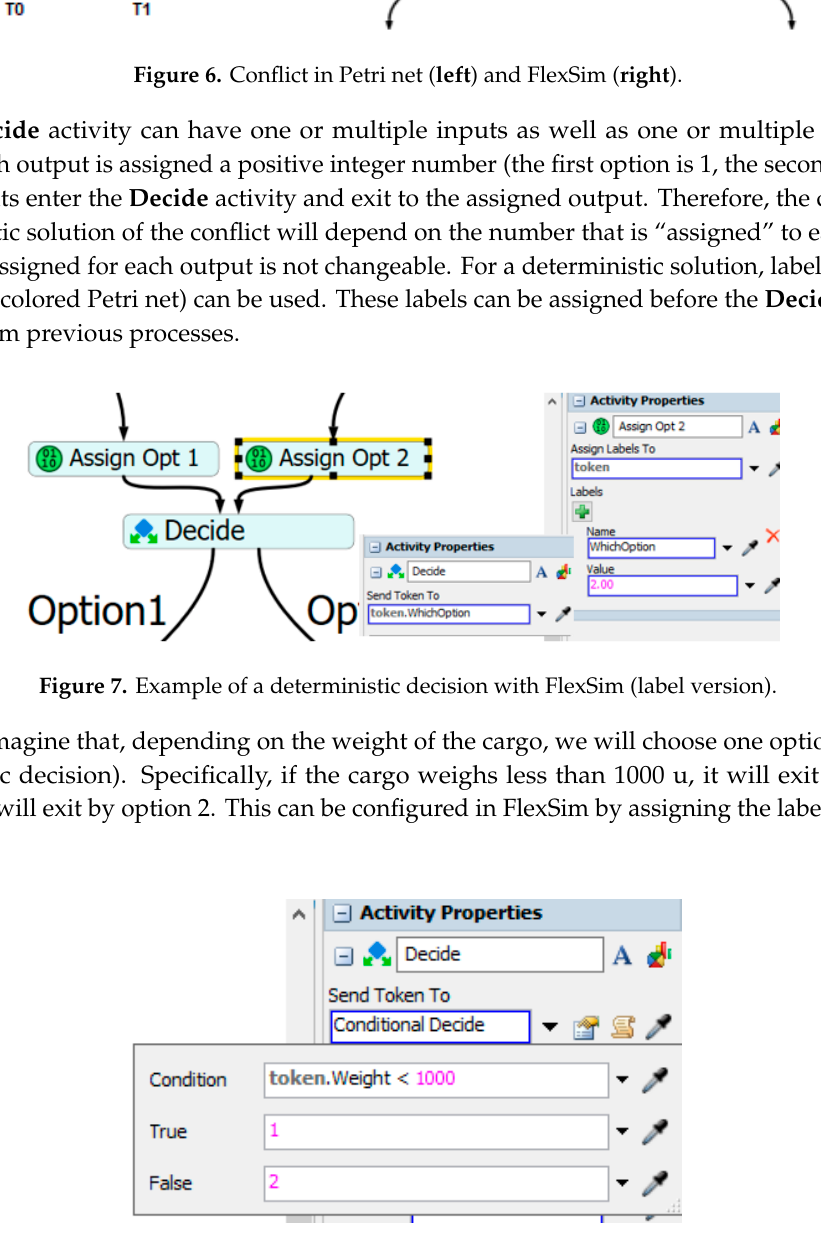
Figure 9. Example of a probabilistic decision with FlexSim. 5.3. Concurrency with Temporal Entities In Figure 10, T1 and T2 transitions are concurrent. Concurrency is an important attribute of system interactions. In order to create concurrent transitions, there must be a forking transition that deposits a temporal entity at two or more output places. This might represent, for example, an AGV that transports two packages and splits the cargo indiscriminately between two conveyor belts. The Split activity in FlexSim deposits temporal entities at two (or more) output places. Figure 10. Concurrency with temporal entities in FlexSim. 5.4. Synchronization with Temporal Entities In Figure 11, places P0 and P1 need to receive an entity in order for T0 to be enabled. Synchronization is common in a dynamic system for an event to occur. This can be represented, for example, by a situation in which two pieces need to be assembled before being transported. The